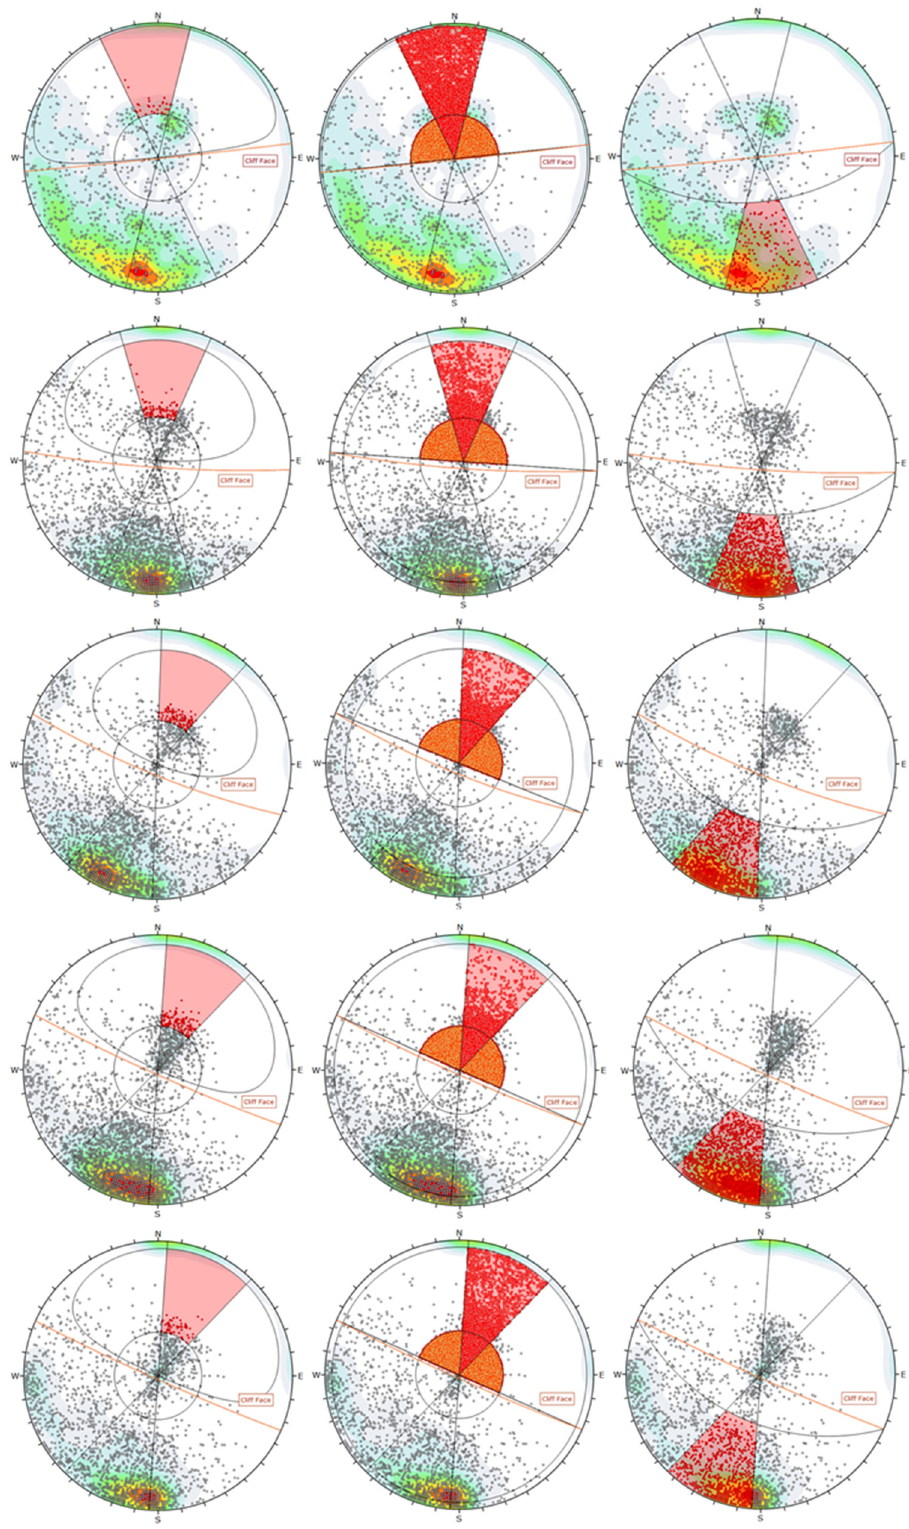
Figure 10. Kinematic analyses of the Raspadalica Cliff by cliff zones according to planar sliding, direct toppling and flexural toppling, conducted using Rocscience Dips software [91]. The results are presented in rows for each zone (e.g., Zone Z1 is in the first row). The results of planar sliding are in the first column, direct toppling in the second column, and flexural toppling in the third column.